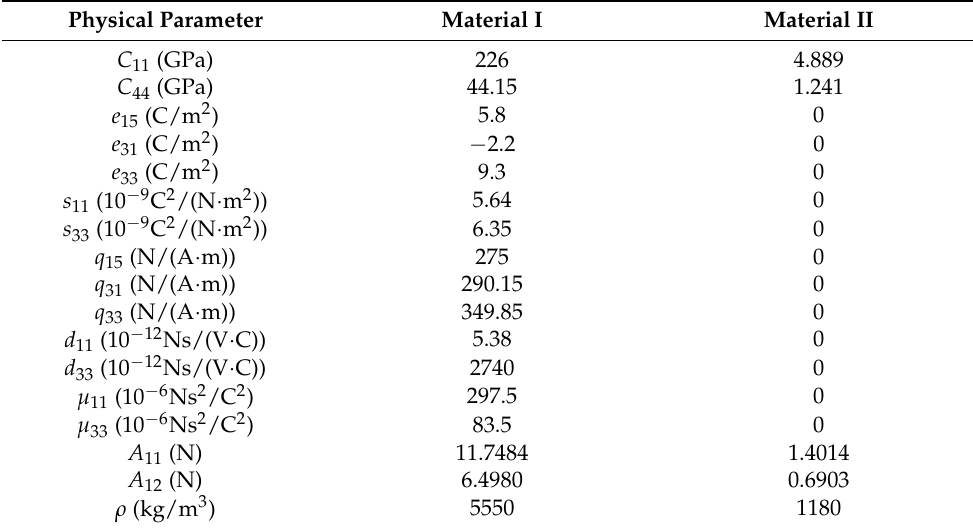
Table 1. Material properties of the BaTiO 3 -CoFe 2 O 4 [39] and epoxy [63].